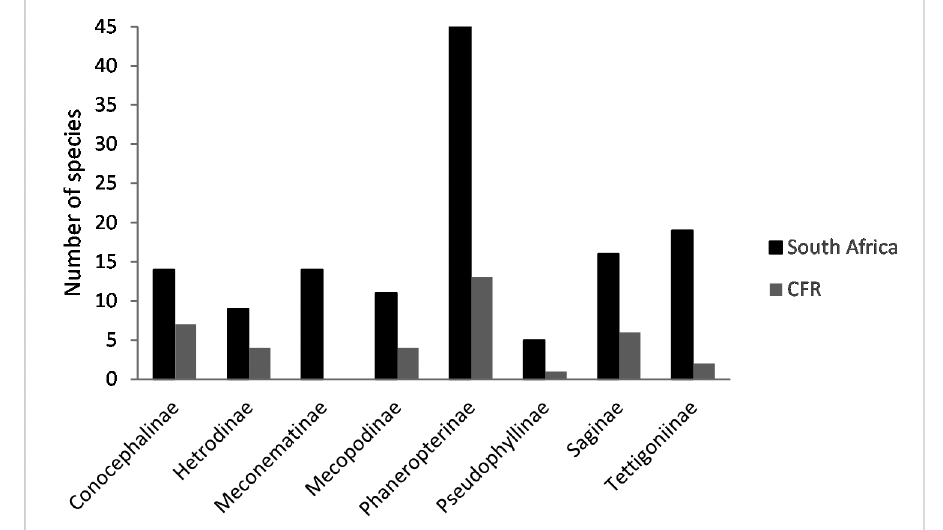
Figure 3. Distribution of South African and Cape Floristic Region katydid species among Tettigoniidae subfamilies.